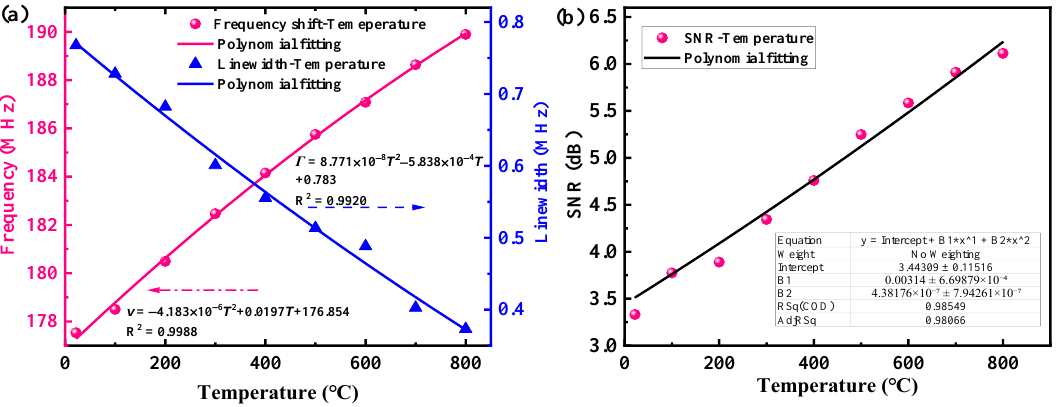
Figure 5. ( a ) Resonance frequency and linewidth of R 0,4 mode induced polarized GAWBS spectra as a function of temperature; ( b ) Measured SNR of the R 0,4 mode induced polarized GAWBS spectra as a function of temperature.